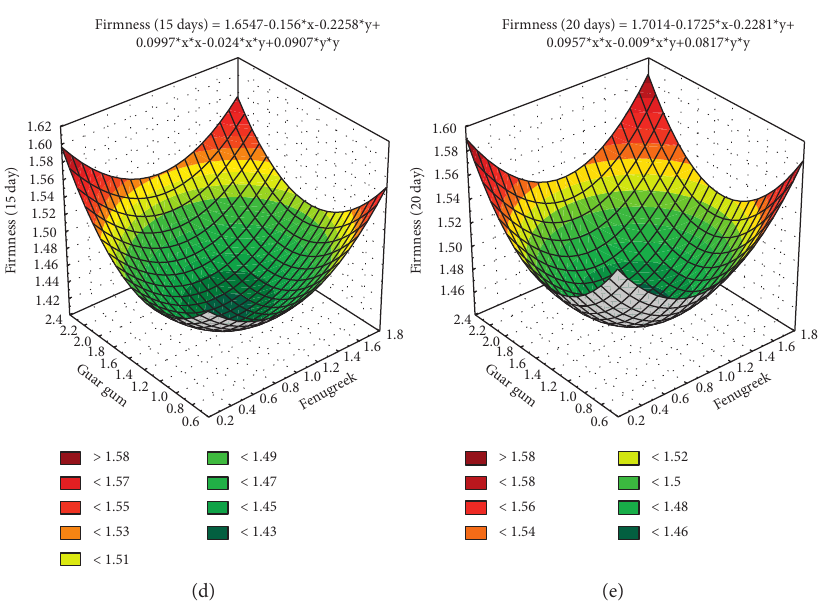
Figure 3: Response surface plot showing the impact of guar galactomannan and fenugreek galactomannan on the firmness of guava fruit during storage. (a) Firmness (0 days) � 1.2139+0.0894 ∗ x +0.1001 ∗ y − 0.021 ∗ x ∗ x − 0.025 ∗ x ∗ y − 0.02 × y ∗ y . (b) Firmness (5 days) �